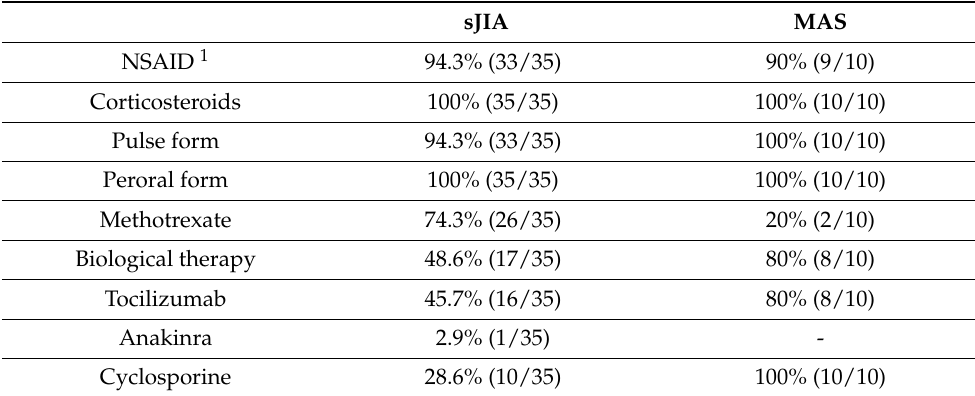
Table 4. Pharmacological treatment in sJIA patients and patients during MAS